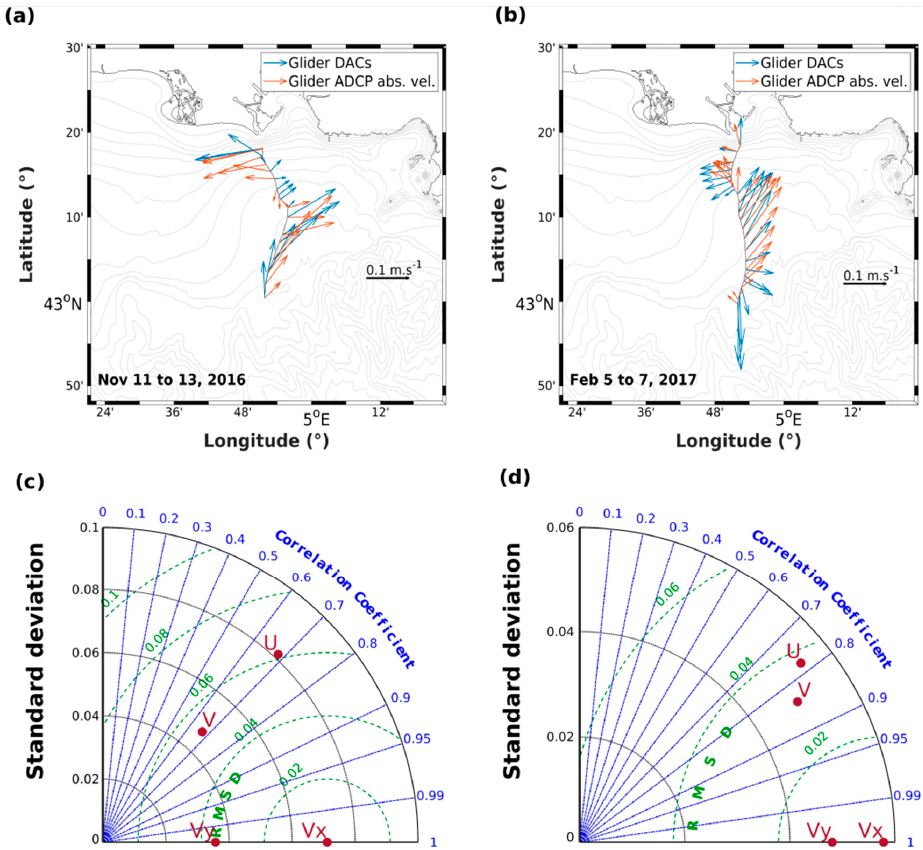
Figure 7. Comparison of depth-averaged current (DAC) vs. ADCP-derived residual current on sections of interest, respectively ( a ) from November 11 to 13, 2016 and ( b ) from February 5 to 7, 2017. Taylor’s diagram comparing the DACs (Vx, Vy) and ADCP-derived residual current (U,V)— respectively for each component of eastward and northward velocity—across an entire deployment, for ( c ) the autumn (November 2016) and ( d ) winter seasons (February 2017).